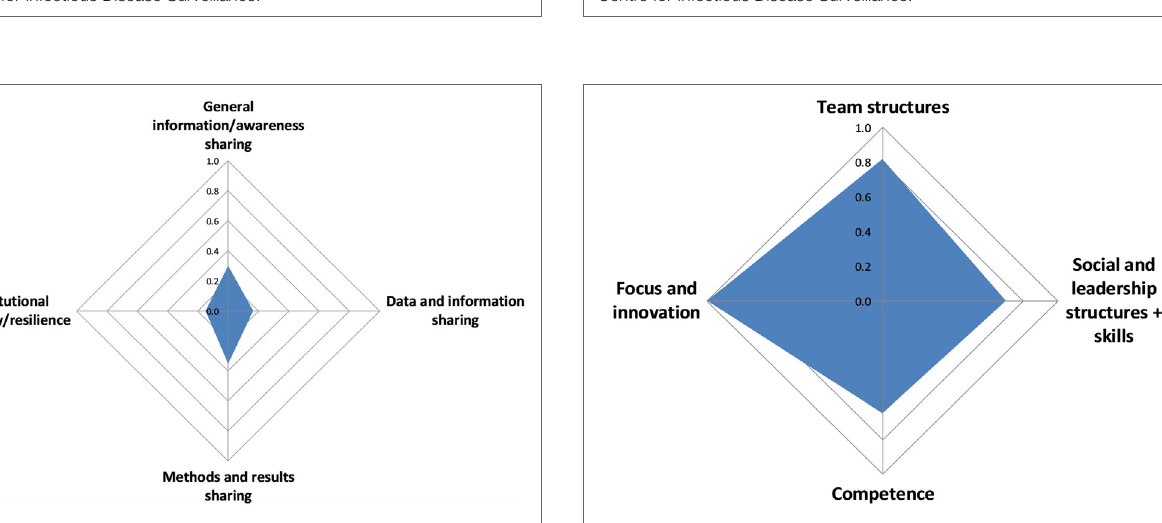
FigUre 8 | Assessment of One Health working in the Southern African Centre for Infectious Disease Surveillance.